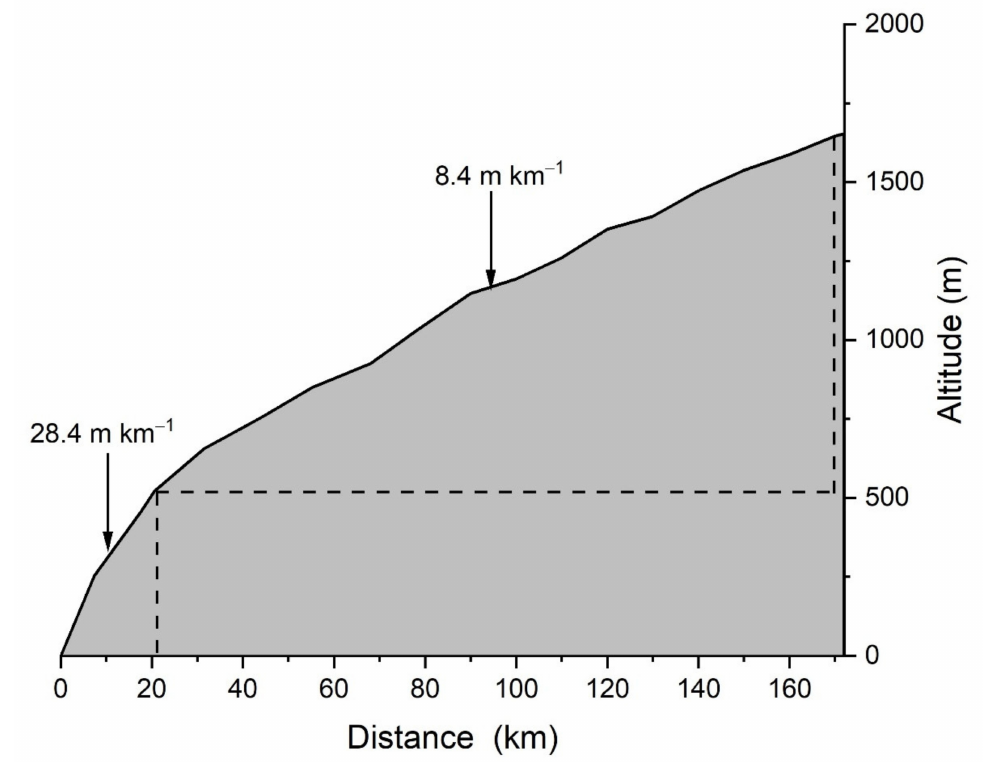
Figure 2. Slope variation along the